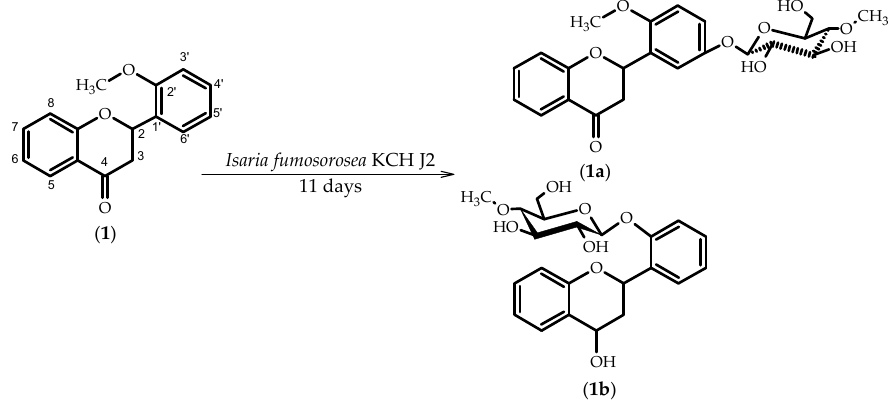
Scheme 1. The microbial transformation of 2 ′ -methoxyflavanone ( 1 ) in the I. fumosorosea KCH J2 culture.